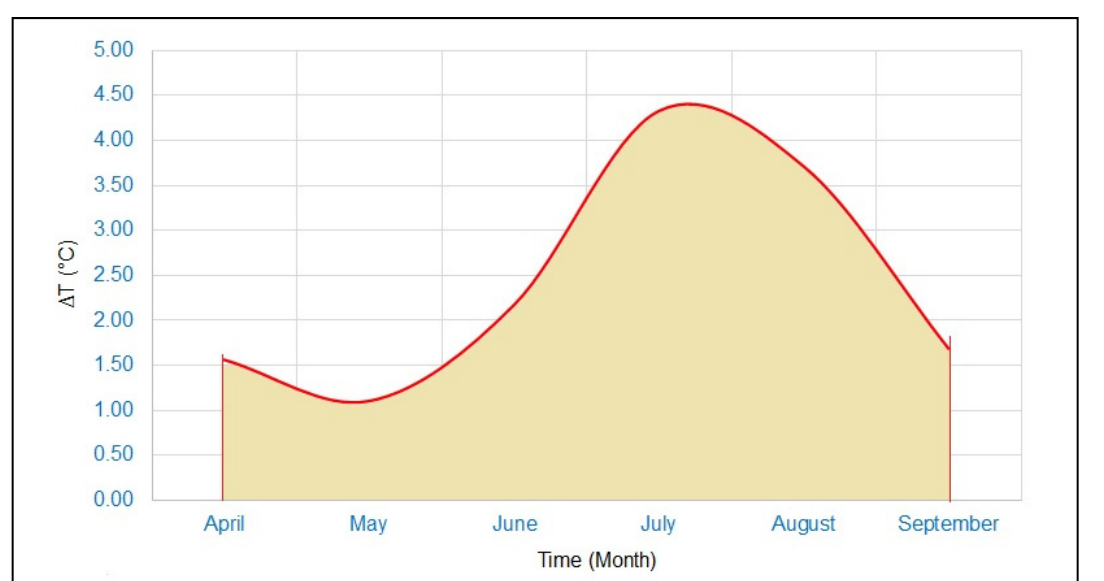
Figure 6. Thermal comfort requirement in a hot dry climate location.